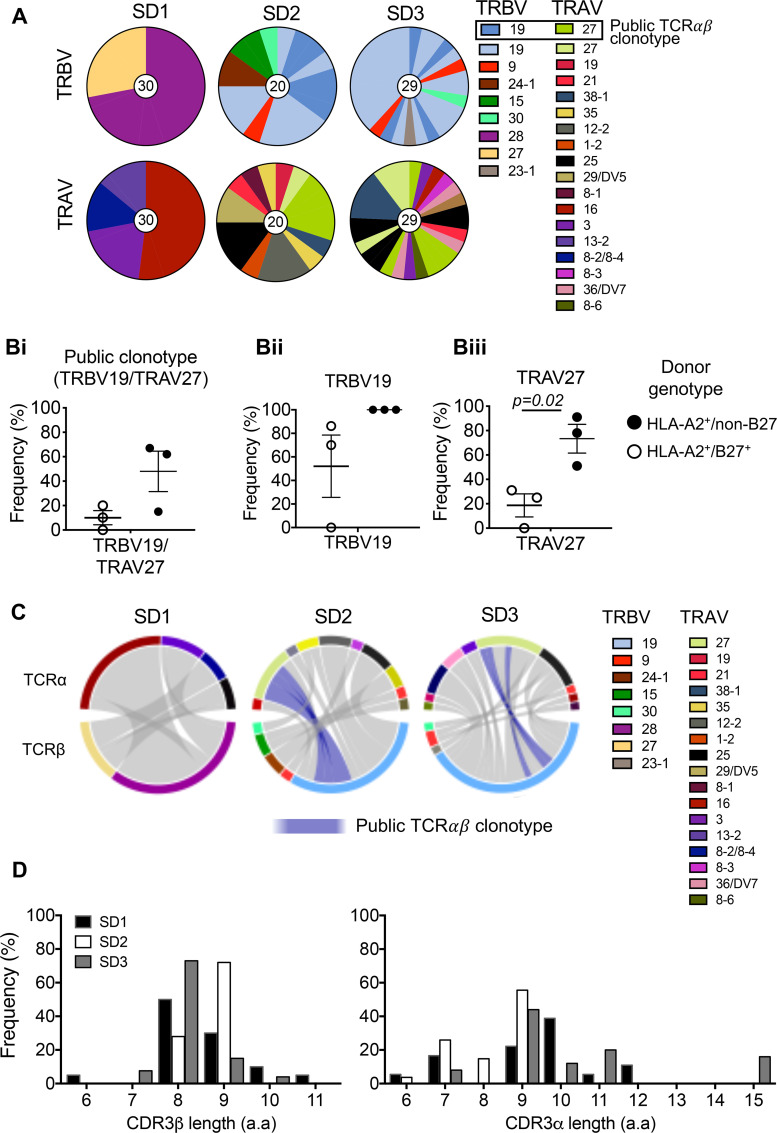
Subdominant A2/M158+ TCRαβ repertoire display reduction in A2/M158-specific “public motif”.(A) Pie charts of TRAV and TRBV usage within subdominant A2/M158+CD8+ T cells in three HLA-A2+/B27+ blood donors. Public TRBV19 and TRAV27 motifs are represented by blue and green shades respectively. (B) Frequencies of the dominant A2/M158-specific gene usage are shown for paired TRBV19/TRAV27 or TRBV19 and TRAV27 groups for our three subdominant HLA-A2+/B27+ donors (SD1-3, open circles) versus previously reported immunodominant HLA-A2+/non-B27 donors (closed circles) [17]. Mean±SEM are shown. (C) Circos plots made in RStudio v.1.2.1335 of paired TCRαβ clonotypes from SD1-3 donors. (D) Frequencies of CDR3β and CDR3α aa lengths are shown for 3 our subdominant donors SD1-3.